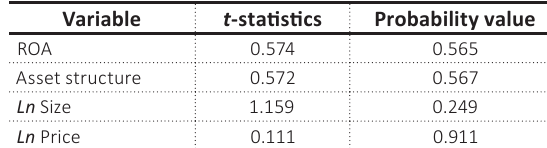
Table 3. Glejser test results